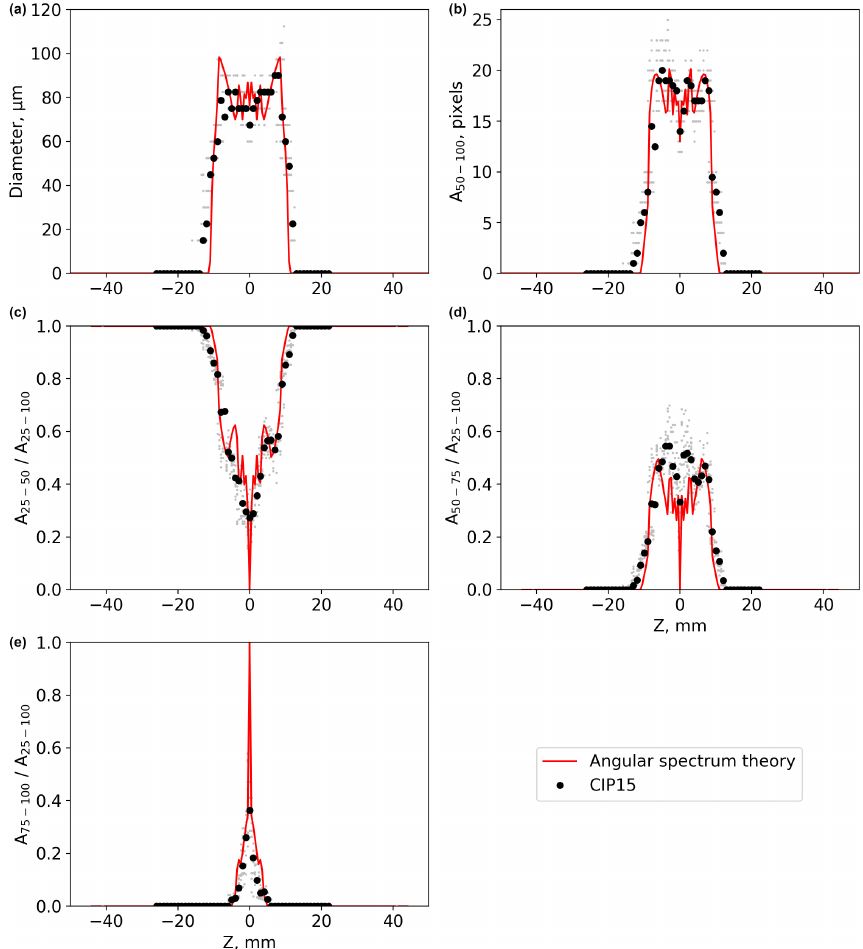
Figure 5. A comparison between CIP-15 images and diffraction simulations (red lines) of the ice crystal analogue ROS118. Grey dots show data from individual CIP-15 images, and black dots show the median for each 1mm Z bin. Panel (a) shows the mean X – Y image diameter. Panel (b) shows the number of pixels using 50% detection thresholds. Other panels show the ratio of the number of pixels (area) at different greyscale